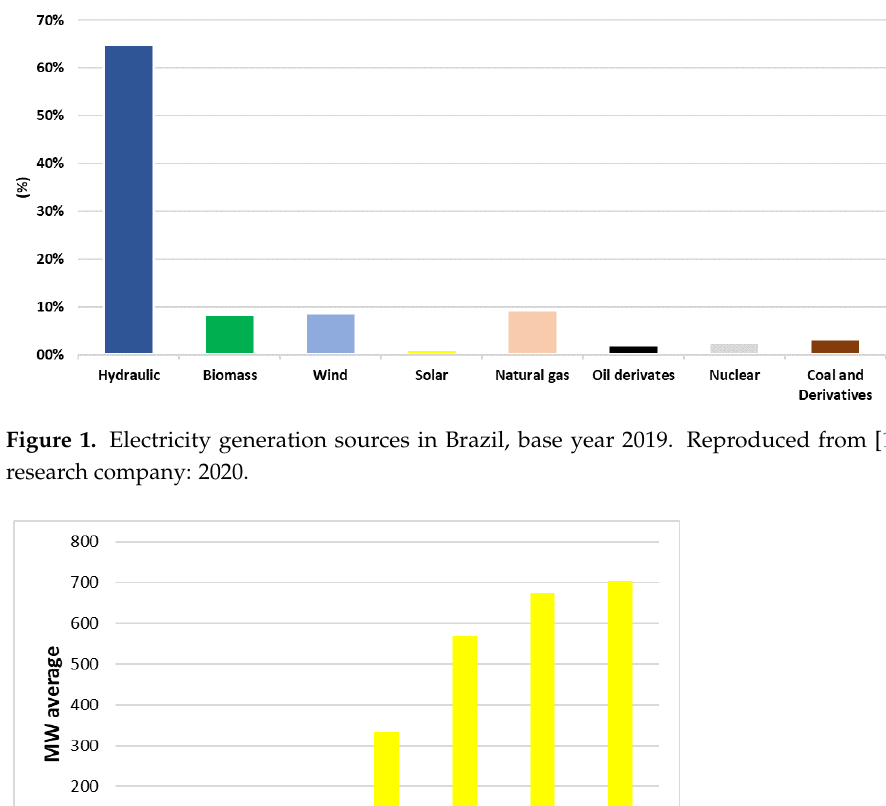
Figure 1. Electricity generation sources in Brazil, base year 2019. Reproduced from [1], Energy research company: 2020.